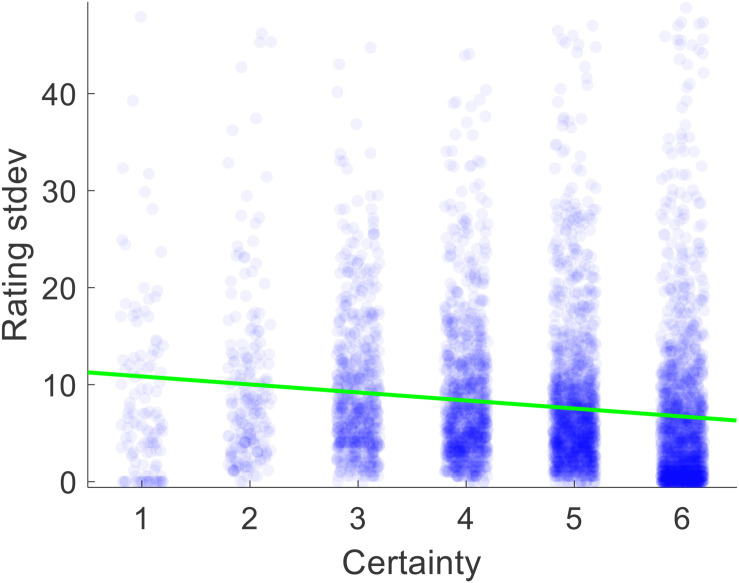
Scatter plot of the relationship between value estimate certainty and the standard deviation of ratings across rounds 1–3, pooled across all participants. Each dot represents one trial.